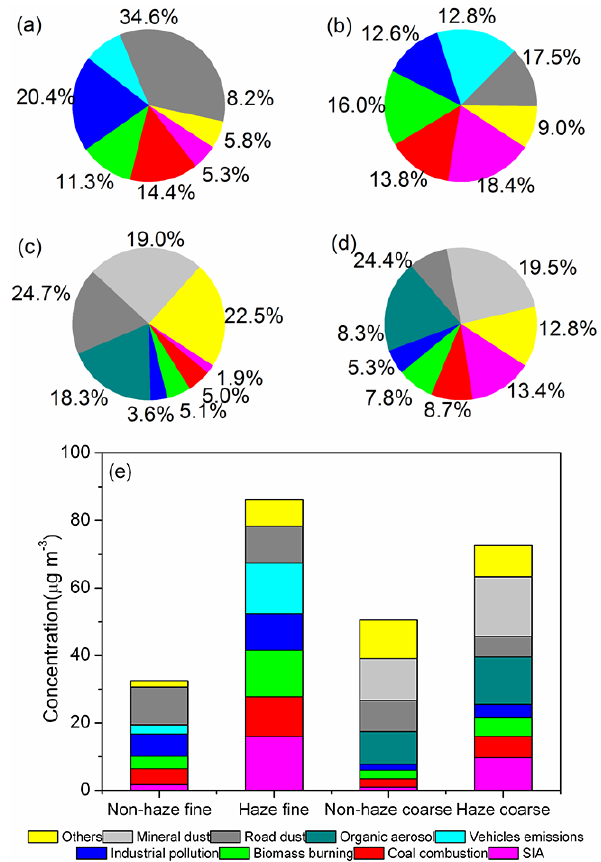
Figure 6. Relative contributions from each identified source to (a) PM 2 . 1 on non-haze days, (b) PM 2 . 1 on haze days, (c) PM 2 . 1 − 9 on non-haze days, (d) PM 2 . 1 − 9 on haze days and (e) mass concen- trations of each source.